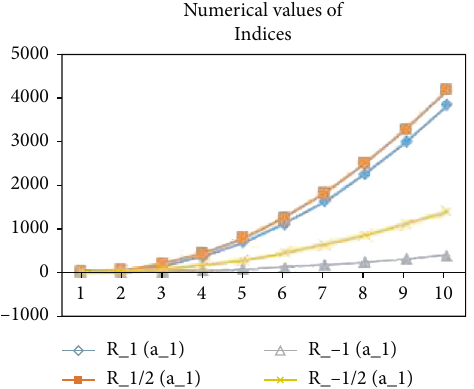
Figure 4: Comparison of indices for HDN4 ð 4 Þ .